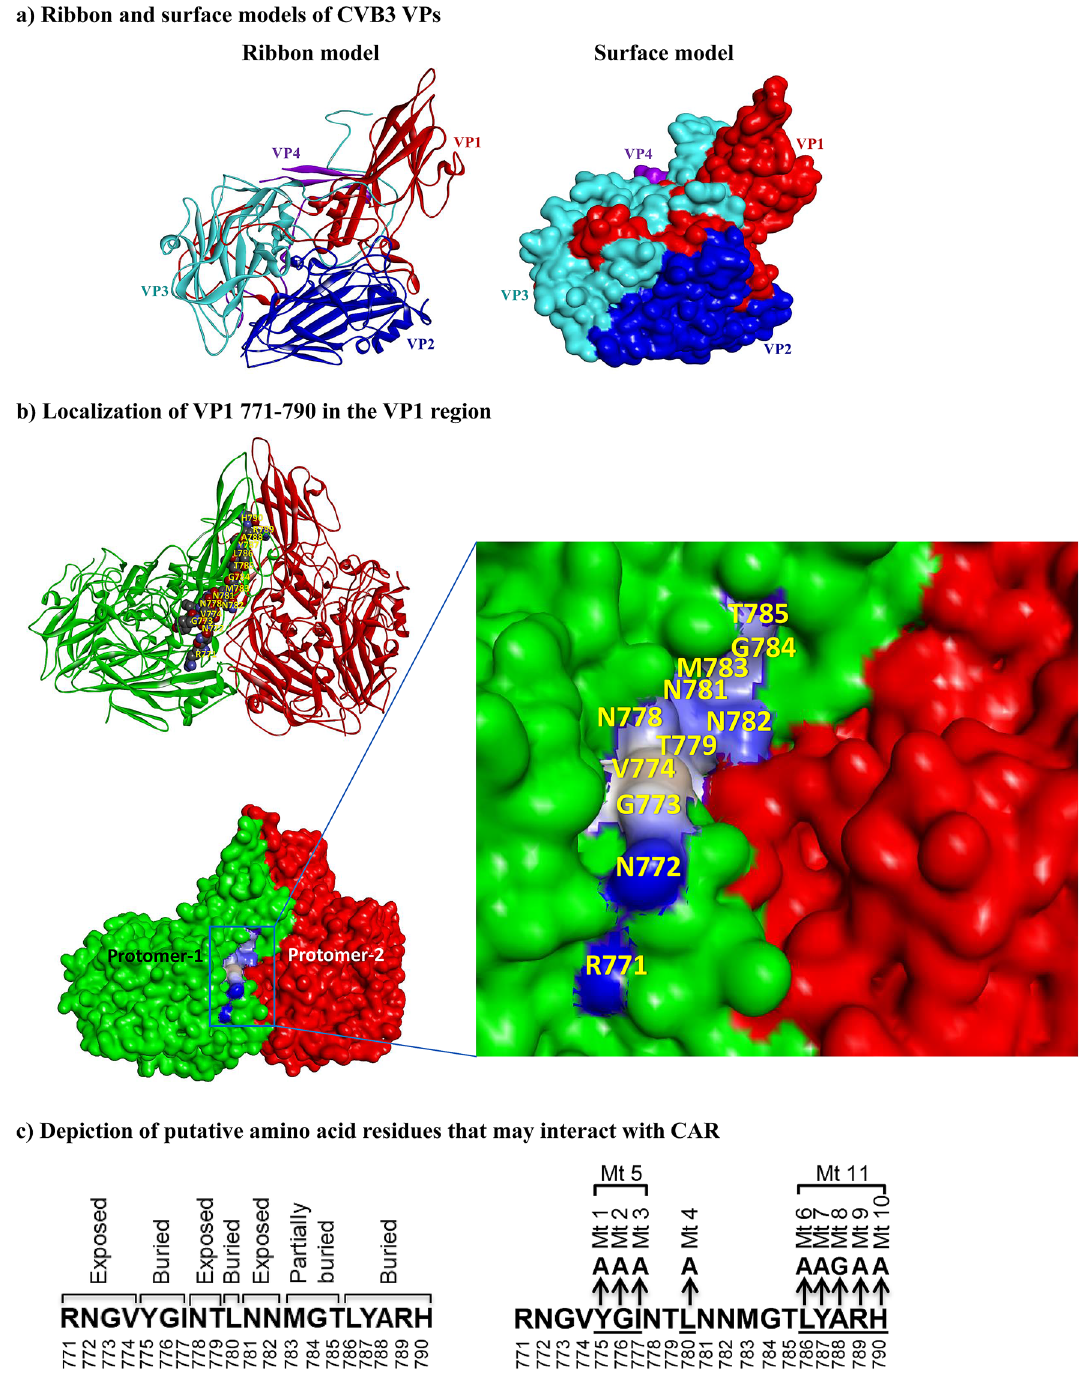
Figure 1. Structural characteristics of VP1 771–790 of CVB3 showing their relationship to the binding region between viral canyon and CAR, and an approach to create mutant viruses. ( a ) Ribbon and surface models of CVB3 VPs. Using the published pentamer structure of CVB3 (PDB: 1COV) 16,17 , all four structural proteins of CVB3 (VP1 [red], VP2 [blue], VP3 [turquoise], and VP4 [purple]) were localized in the protomer, as illustrated in the ribbon (left panel) and surface (right panel) models. ( b ) Localization of VP1 771–790 in the VP1 region. The amino acid residues of VP1 771–790, depicted in balls between two protomers (green and red) are shown in the top panel, and their positions are indicated in yellow. The surface model (bottom panel) shows the exposed amino acid residues that may potentially interact with the CAR; their positions are shown in yellow in the inset. The interactions of VP1 771–790 with CAR were analyzed using the BIOVIA Discovery Studio v4.0 (https:// www. discn gine. com/ disco very- studio). ( c ) Depiction of putative amino acid residues that may interact with CAR. After localizing the residues within the VP1 region in relation to CAR as described above, the putative residues that potentially interact with the host receptor CAR were identified as exposed residues (RNGV, NT, and NN), whereas YGI, L, and LYARH were identified as buried residues, which are not expected to interact with CAR (left panel). The right panel represents mutations introduced at various positions individually or in